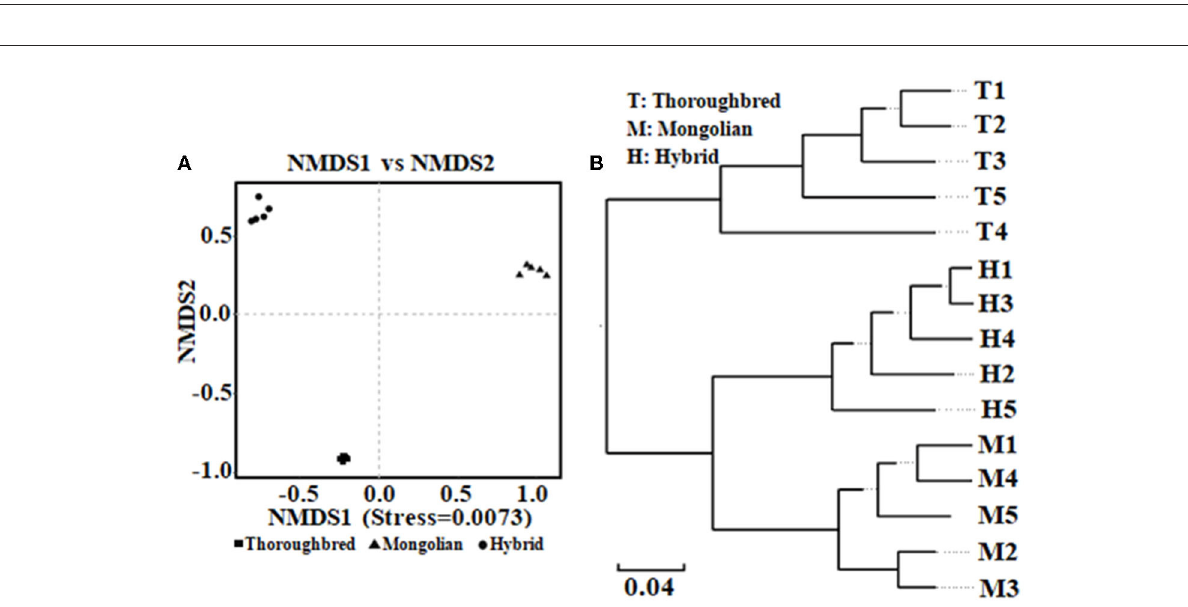
7.21, which was significantly higher than that in Mongolian (5.66, P < 0.01) and Hybrid horses (5.91, P < 0.01)